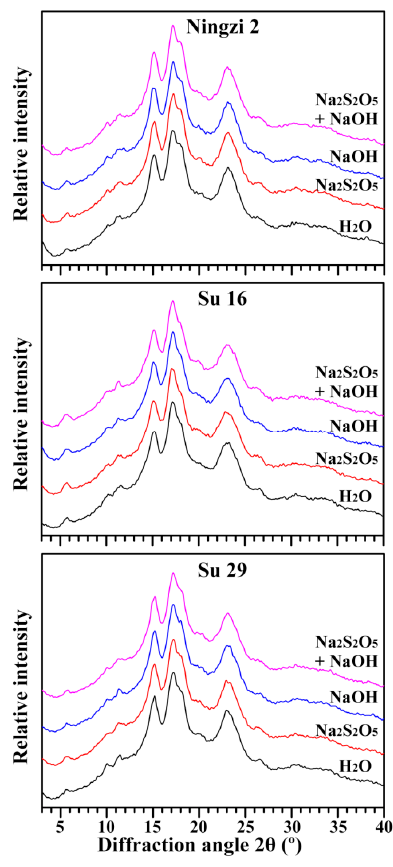
Figure 4. XRD patterns of starches.